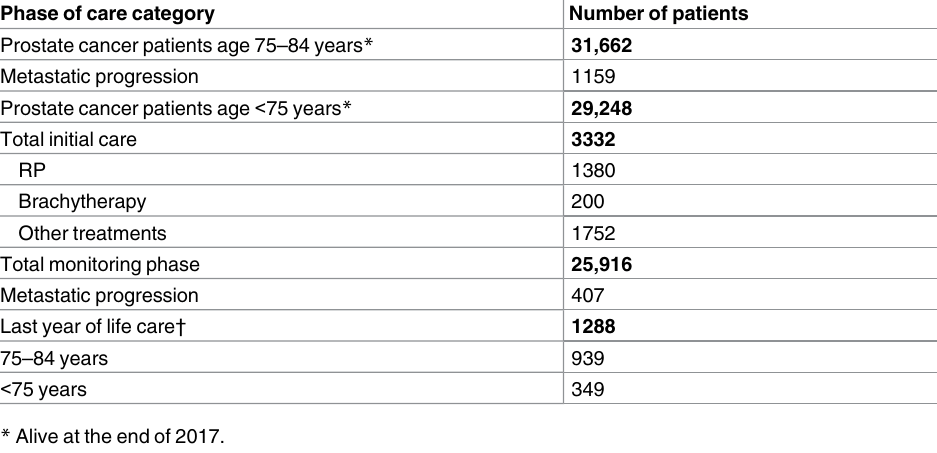
Table 1. Estimatesof numbers of patients within each phase of care in 2017, NSW